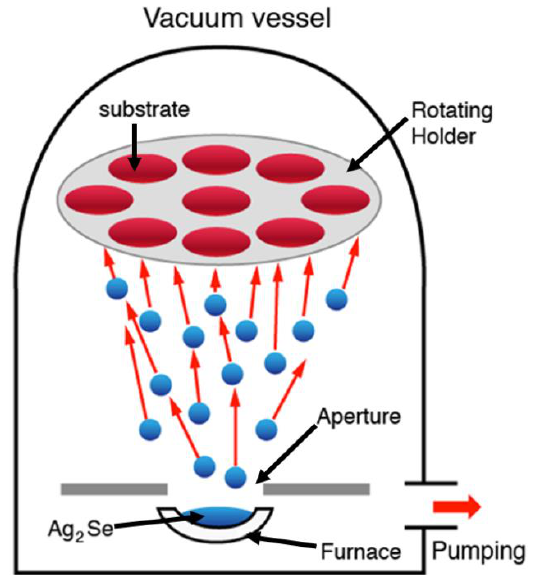
Figure 1. Vacuum thermal evaporator used for the deposition of Ag 2 Se films.